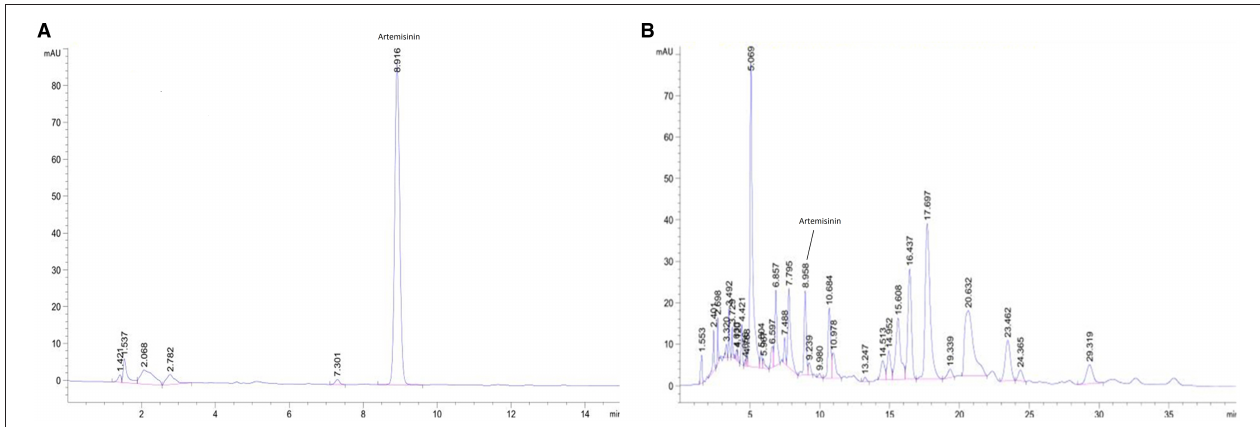
FIGURE 2 | HPLC chromatogram for detecting artemisinin in QHP. (A) Artemisinin control. (B) Sample of QHP.